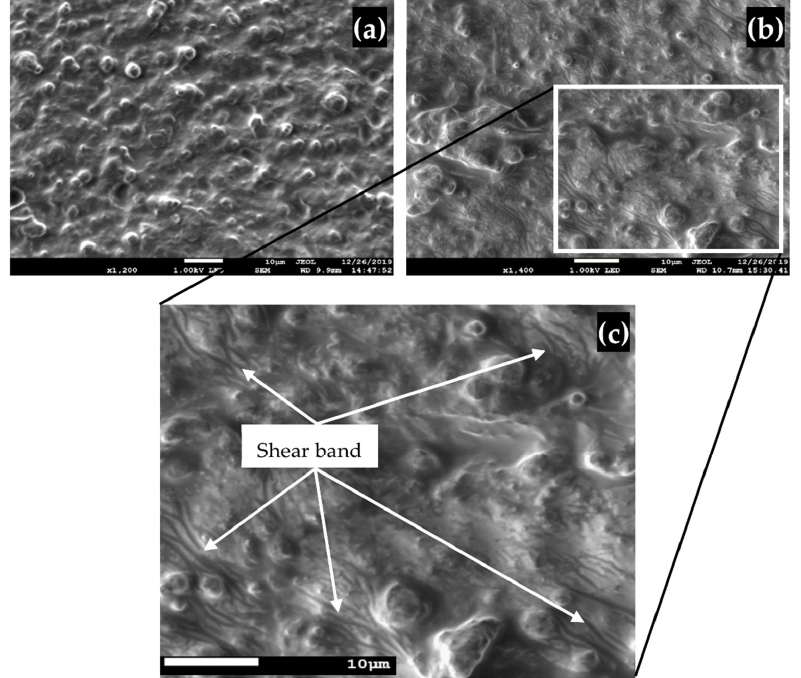
Figure 7. FESEM images of MRE samples before and after durability test: ( a ) MRE before durability evaluation; ( b ) sample after durability by stress relaxation; and ( c ) view of the shear band deformation in the MRE matrix in greater detail.